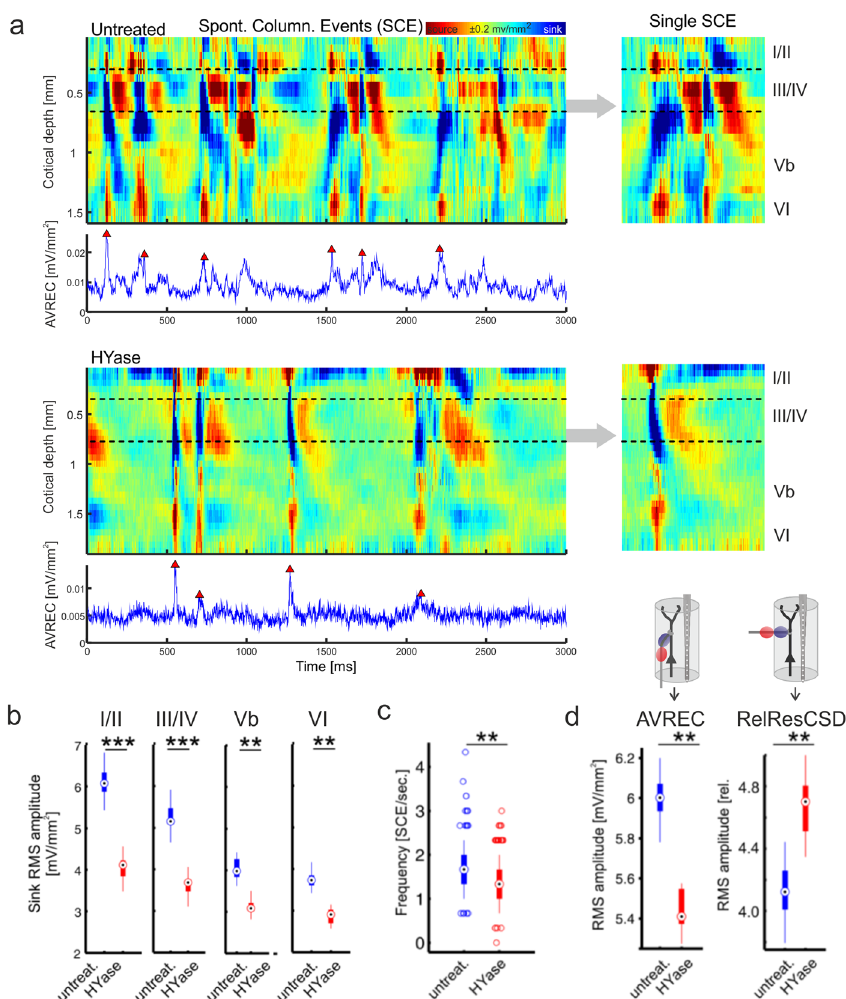
Fig. 6 Injection of HYase reduced the frequency of spontaneous columnar events and increased cross-columnar activity spread. a Top , Recordings of spontaneous activity showed the occurrence of spontaneous events of translaminar synaptic information fl ow mimicking evoked columnar feedforward activation pro fi les called spontaneous columnar events. SCE ’ s in untreated cortex showed information fl ow starting from pacemaker activity in layer Vb (see inset right). Bottom , After Injection of HYase SCE ’ s were shorter in duration, showed no infragranular pacemaker structure and did not expand through all cortical layers (see inlay right). Frequency of SCE ’ s was quanti fi ed by peak detection of the AVREC trace based on crossings of 3 SD above baseline (blue traces). b Mean RMS amplitudes (±SEM) within separate cortical layers were all signi fi cantly reduced after HYase treatment. c Frequency of SCE ’ s per second was signi fi cantly reduced after HYase treatment. d Decreased RMS amplitude of the AVREC ( ± SEM) was paralleled with a signi fi cant increase of the RMS amplitude (±SEM) of the RelResCSD. Box plots represent the median (circle) and the interquartile range (25% and 75% percentile). The whiskers represent the full range of data. Plotted single data represent outliers. Asterisks mark signi fi cant differences between groups (paired Student ’ s t-test, ** p < 0.01; *** p <